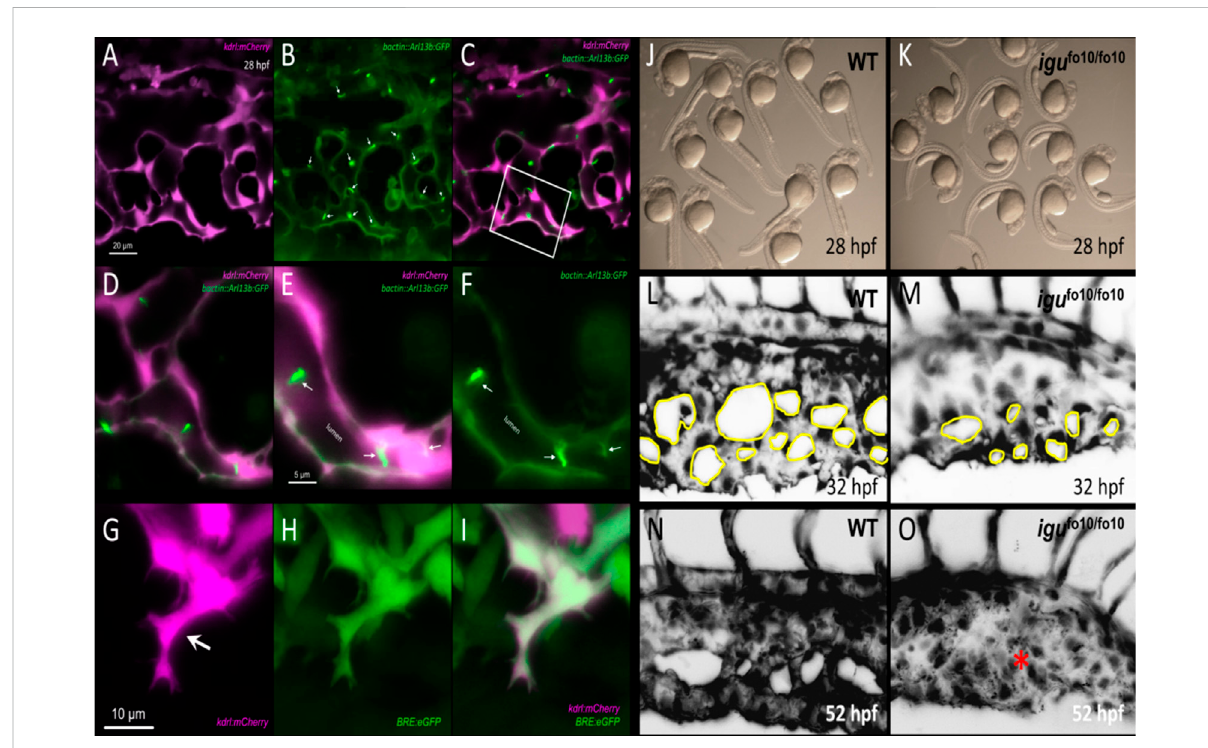
FIGURE 3 Involvement of primary cilia in the emergence of the caudal vein plexus (CVP). (A – C) Representative single stack confocal images of the CVP region in the Tg ( kdrl:mCherry-CAAX) y171 ; ( bactin::Arl13b:GFP) double transgenic embryo at approximately 28 h post fertilization (hpf). ECs express mCherry and primary cilia are labeled by GFP expression. (D – F) Higher magni fi cation of the white boxed region in C. White arrows point to primary cilia. (G – I) Representative maximum projection confocal images of a venous sprout in the CVP region at approximately 28 hpf in the Tg ( kdrl: mCherry-CAAX) y171 ; ( BRE:eGFP) double transgenic embryom showing endothelial cells (mCherry) and BMP-responsive (BRE+) cells (eGFP) at approximately 28 hpf. White arrow points to a tip cell (J) Representative photomicrograph of wild-type embryos at approximately 28 hpf.